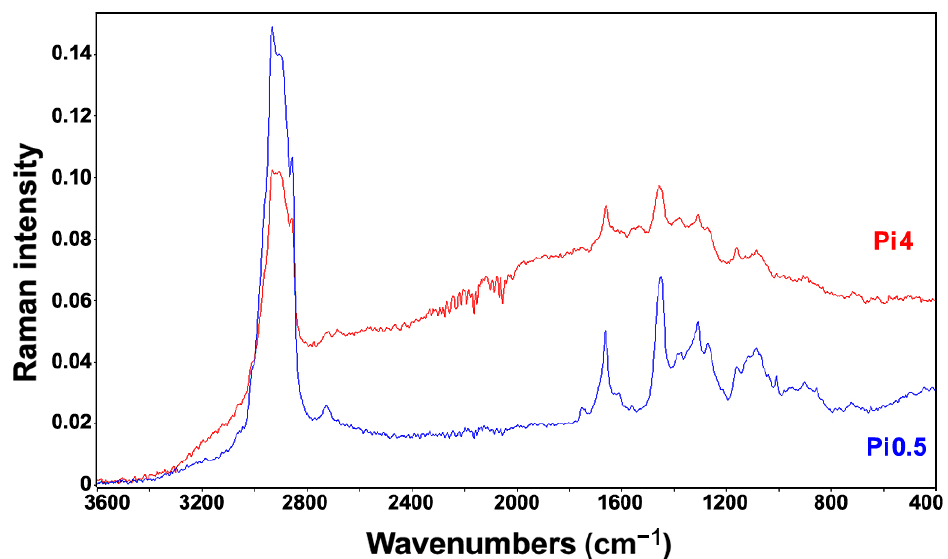
Figure 3. FT-Raman spectra of Rhizopus stolonifer cultivated under Ca1 condition and two different phosphate concentrations. The spectrum of the sample cultivated under high phosphate concentration (Pi4, red) shows a significant heating effect resulting with a distorted baseline even when measured under low excitation laser power (200 mW), compared to the spectrum of the sample cultivated under low phosphate concentration (Pi0.5, blue), which was measured under the standard laser power (500 mW).